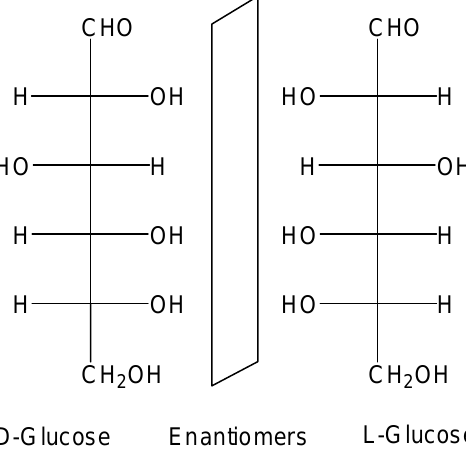
Figure 1. The Fisher projection of D -, L